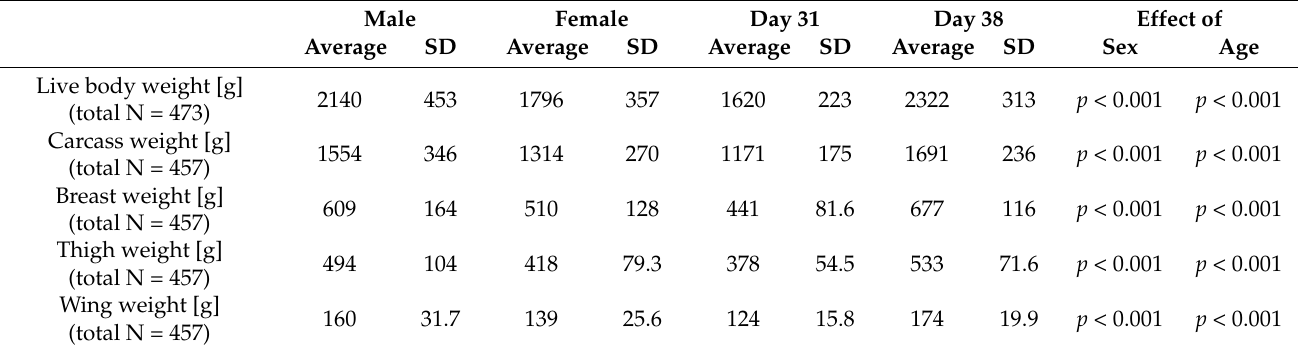
Table 3. Performance parameters of male and female broilers (average value of day 31 and day 38) and on day 31 and day 38 (average value of males and females) within four replicates. Male